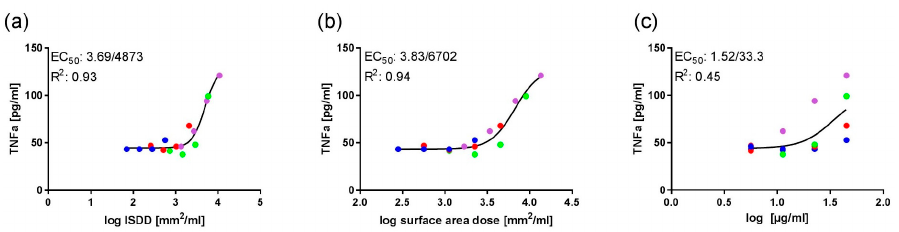
Figure 2. Combined evaluation of TNF α release induced by 9 nm SiO 2 , 15 nm SiO 2 , 30 nm SiO 2 , and 55 nm SiO 2 in the NR8383 AM assay. Purple dots: 9 nm SiO 2 ; green: 15 nm SiO 2 ; red: 30 nm SiO 2 ; blue: 55 nm SiO 2